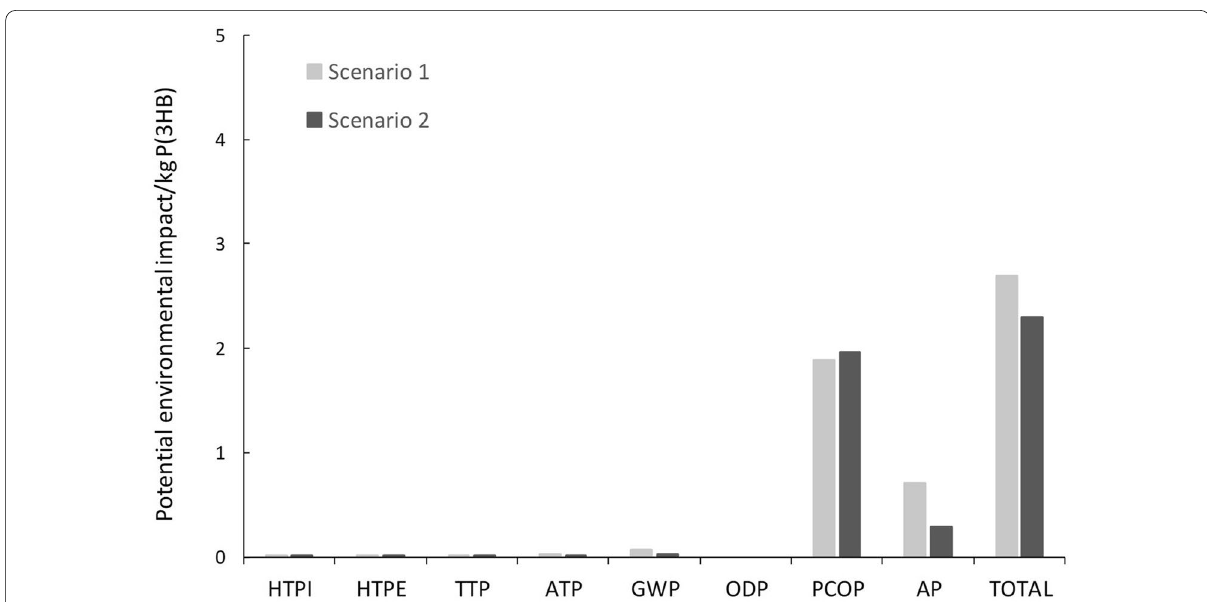
Fig. 2 Potential environmental impact (PEI) per kg of P3HB produced. HTPI human toxicity potential by ingestion, HTPE human toxicity potential by dermal exposure and inhalation, ATP aquatic toxicity potential, AP acidification or acid rain potential, TTP terrestrial toxicity potential, PCOP photochemical oxidation potential, GWP global warming potential, ODP ozone depletion